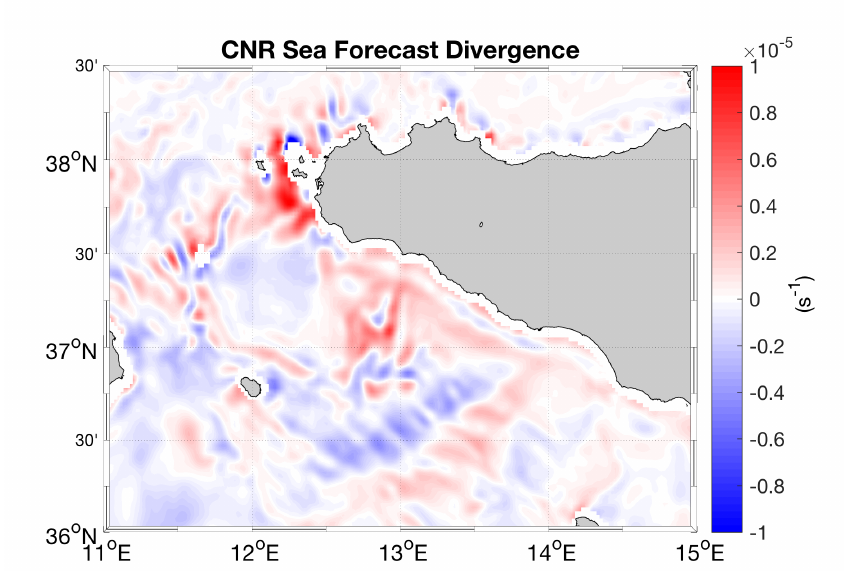
Figure 7. Divergence of the surface currents field in the Sicily Channel (July 2016 monthly average). Prediction of the CNR-Sea Forecast submesoscale-permitting operational model for the Sicily Channel and the Tyrrhenian Sea.